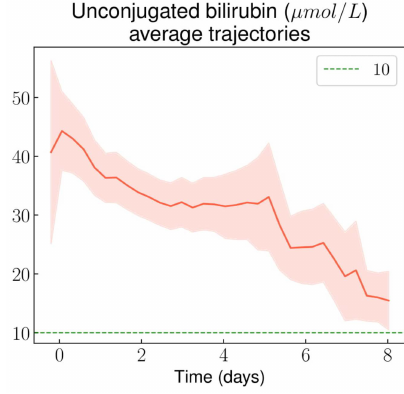
Figure A7. Lactate dehydrogenase (LDH) average trajectory throughout non-complicated VOC-related hospital stays.